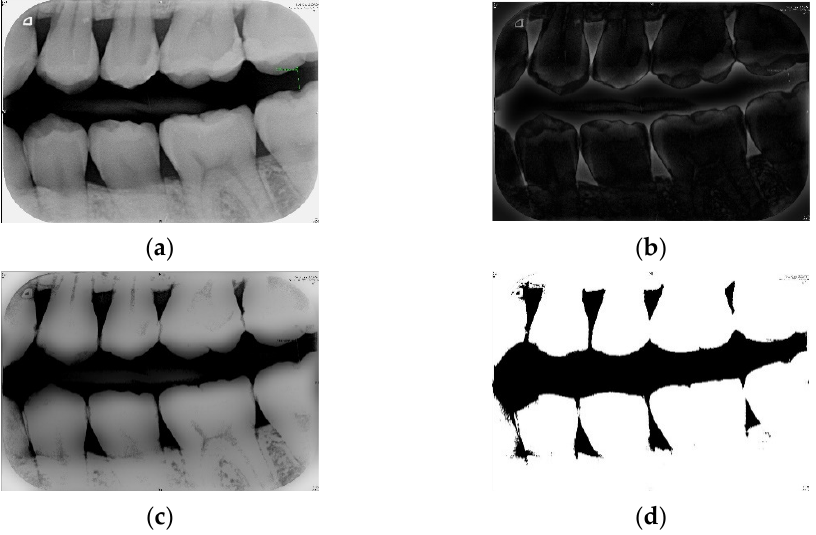
Figure 2. ( a ) The bitewing film; ( b ) the filtered result of ( a ) using the Gaussian high-pass filter; ( c ) the result of ( a ) minus ( b ); ( d ) the result of ( c ) after the